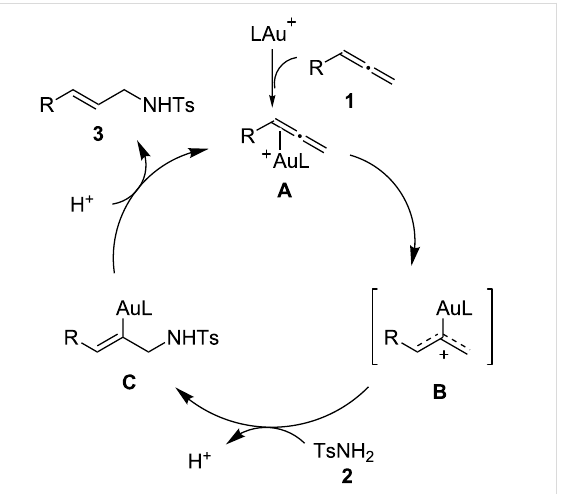
Scheme 1: Proposed mechanism for the hydroamination of